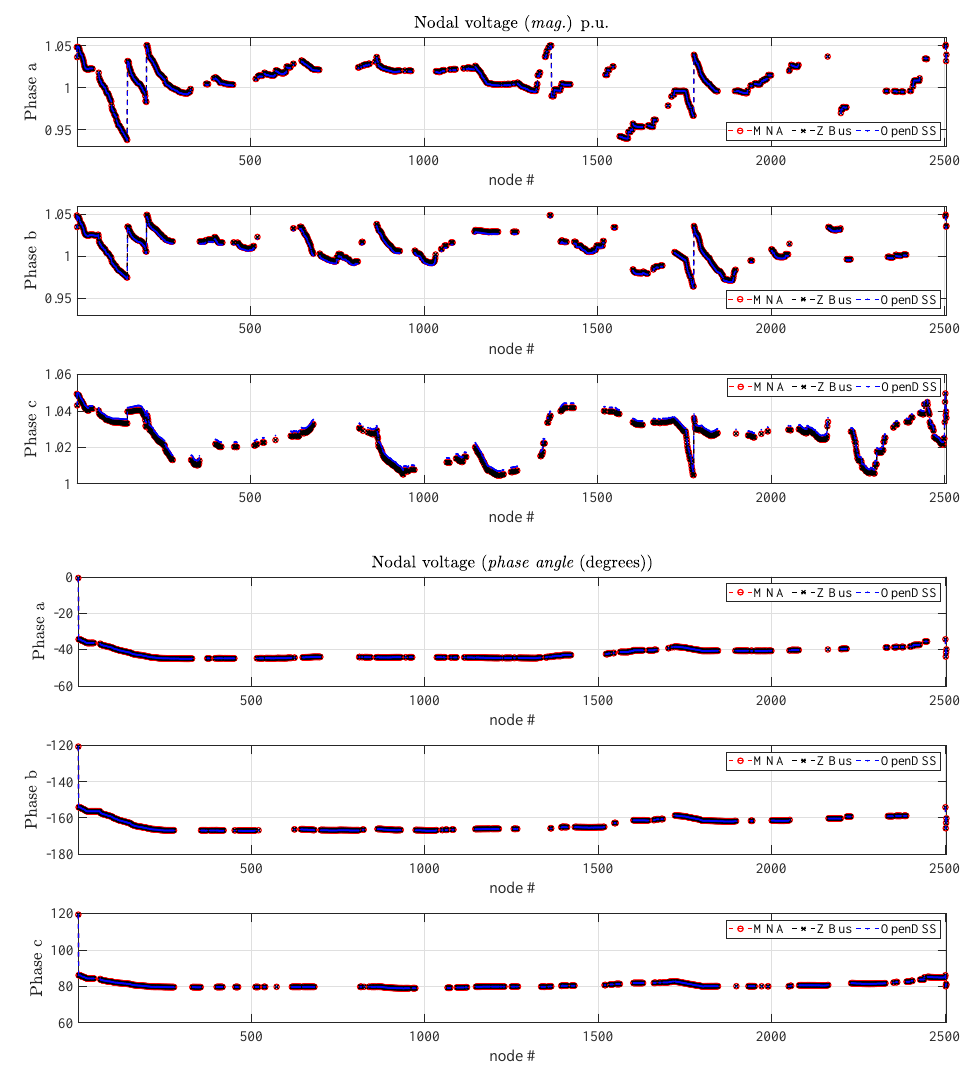
Figure 3. Three-phase voltage profile of the IEEE-8500 test feeder computed by means of the proposed modified nodal analysis (MNA) method, the Z Bus approach and via the open source distribution system simulator (OpenDSS) tool. ( top ) Phase magnitudes (per unit), ( bottom ) phase angles (degrees).